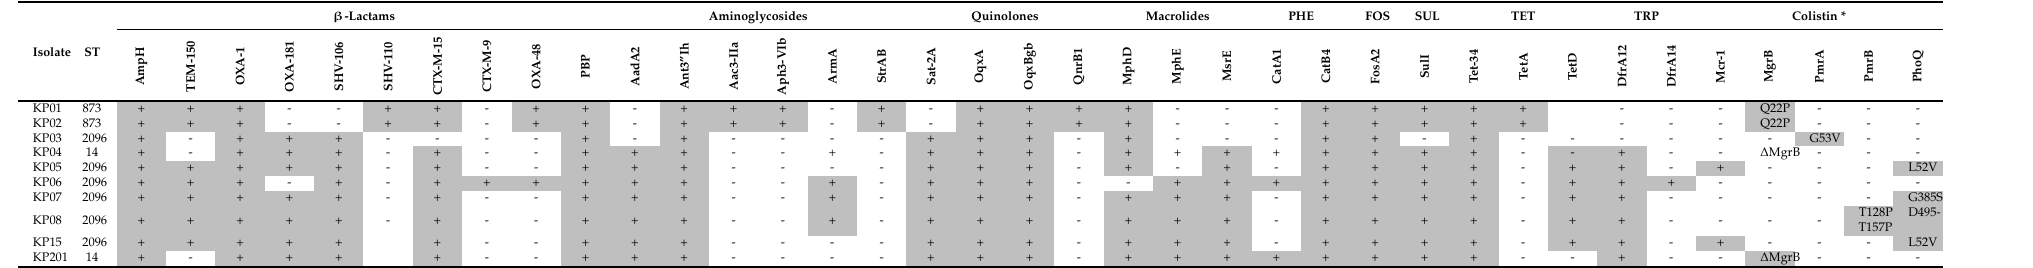
Table 2. Resistome of the 10 clinical K. pneumoniae isolates in this study.